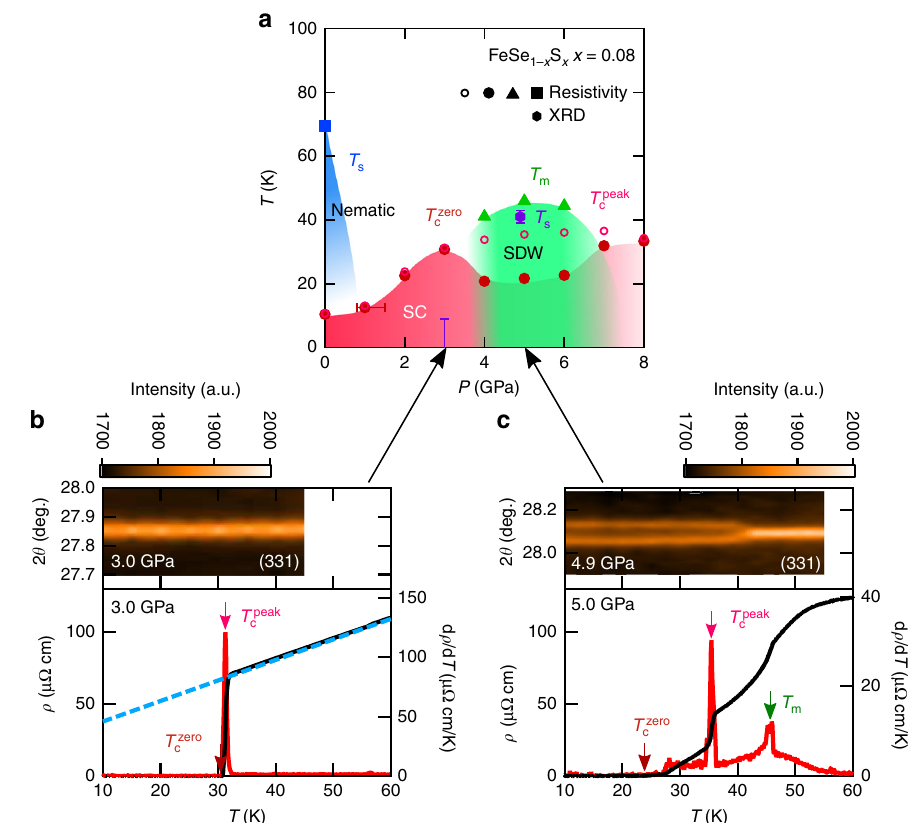
Fig. 3 Temperature-pressure phase diagram for x = 0.08. a T − P phase diagram of FeSe 1 − x S x ( x = 0.08) together with T s determined by the high-pressure synchrotron X-ray diffraction (XRD) in a diamond anvil cell (purple hexagon with error bars). b , c Temperature dependence of Bragg intensity as a function of 2 θ angle is indicated in colour scale for 3.0 GPa ( b ) and 4.9 GPa ( c ). ρ ( T ) and d ρ /d T are also shown with the same horizontal axis. The red, pink and green arrows indicate T zero , T peak and T m , respectively. The blue dashed line in b is a T -linear fi t to the normal-state ρ ( T ) at 3.0 c c